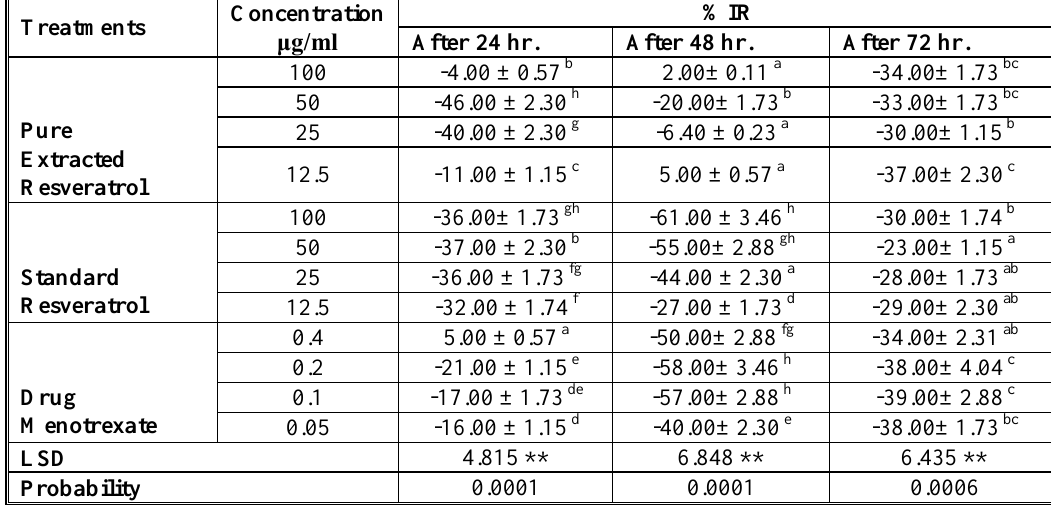
Table 3: The cytotoxic effect as inhibition rate percent (%IR) of extracted pure resveratrol and trans- resveratrol standard and methotrexate drug on Ref cell line at (24,48 and 72) hours of exposure SE= Standard